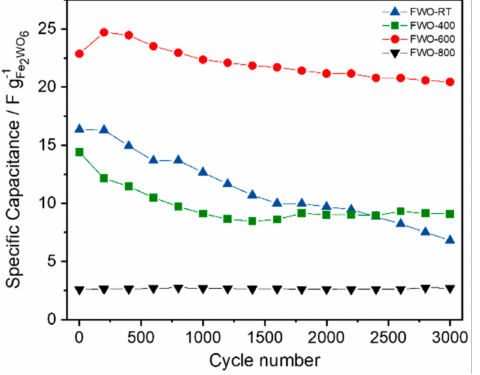
Figure 4. Cycling stability up to 3000 cycles at 20 mV s − 1 in 5M LiNO 3 for the selected Fe 2 WO 6 samples.